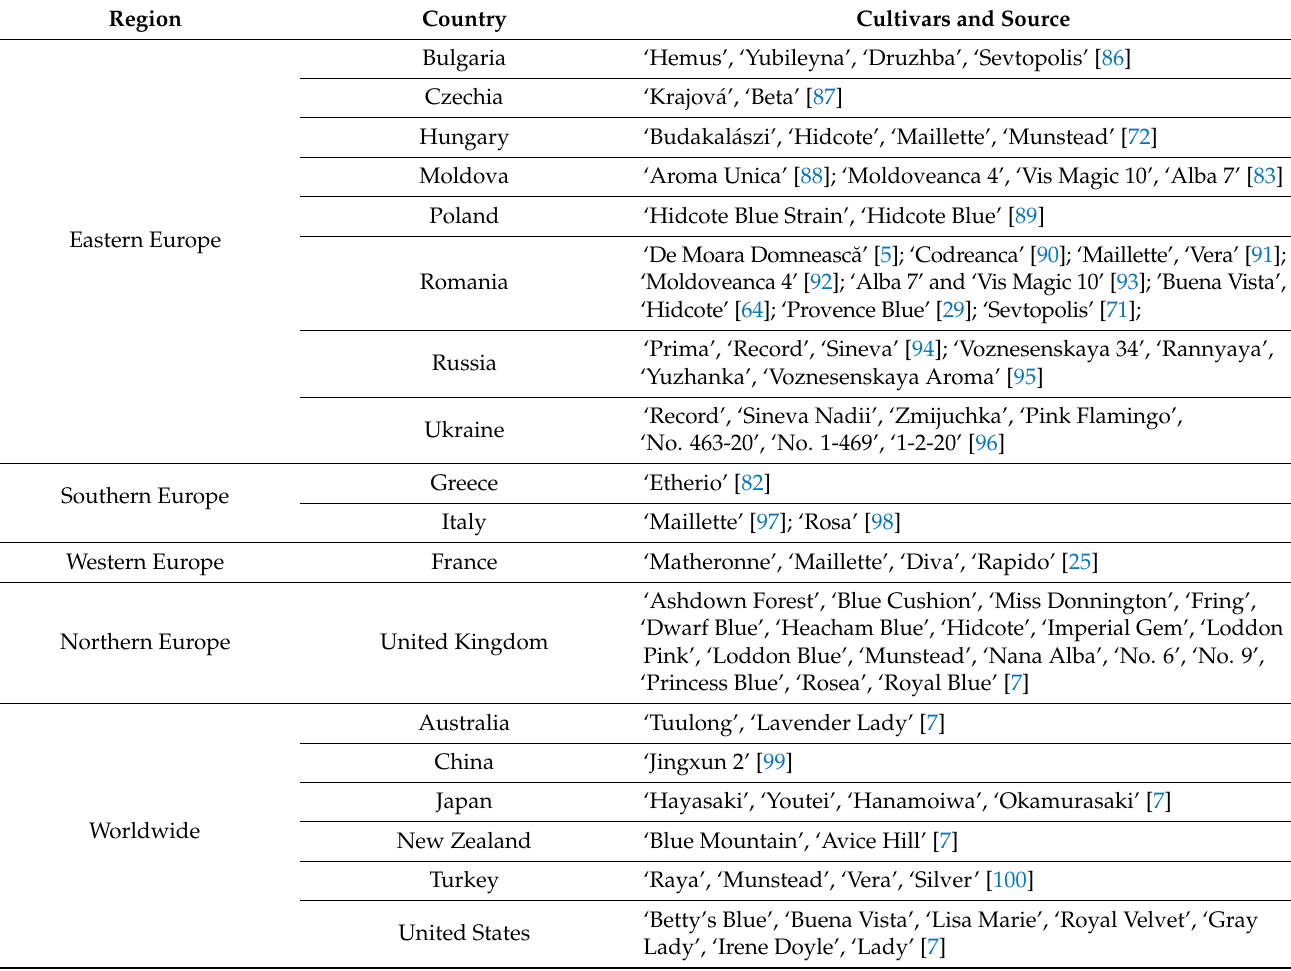
Table 1. Genotypes of L. angustifolia cultivated in various regions according to